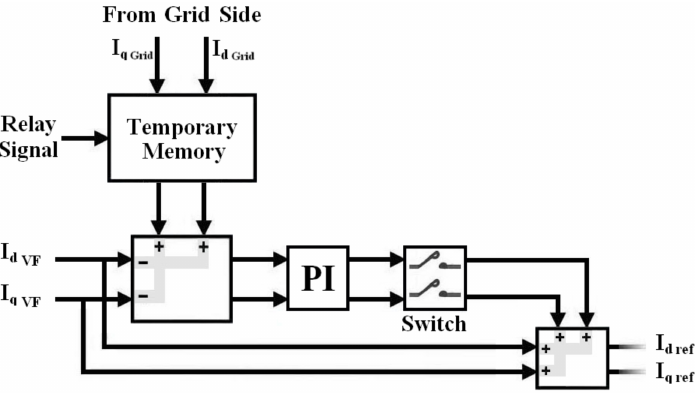
Figure 7. Transition control for unplanned